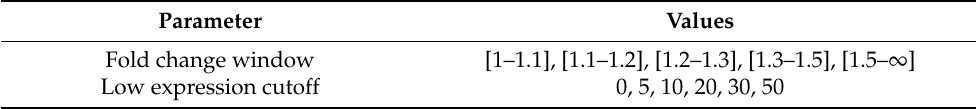
Table 3. Parameter settings in experimental